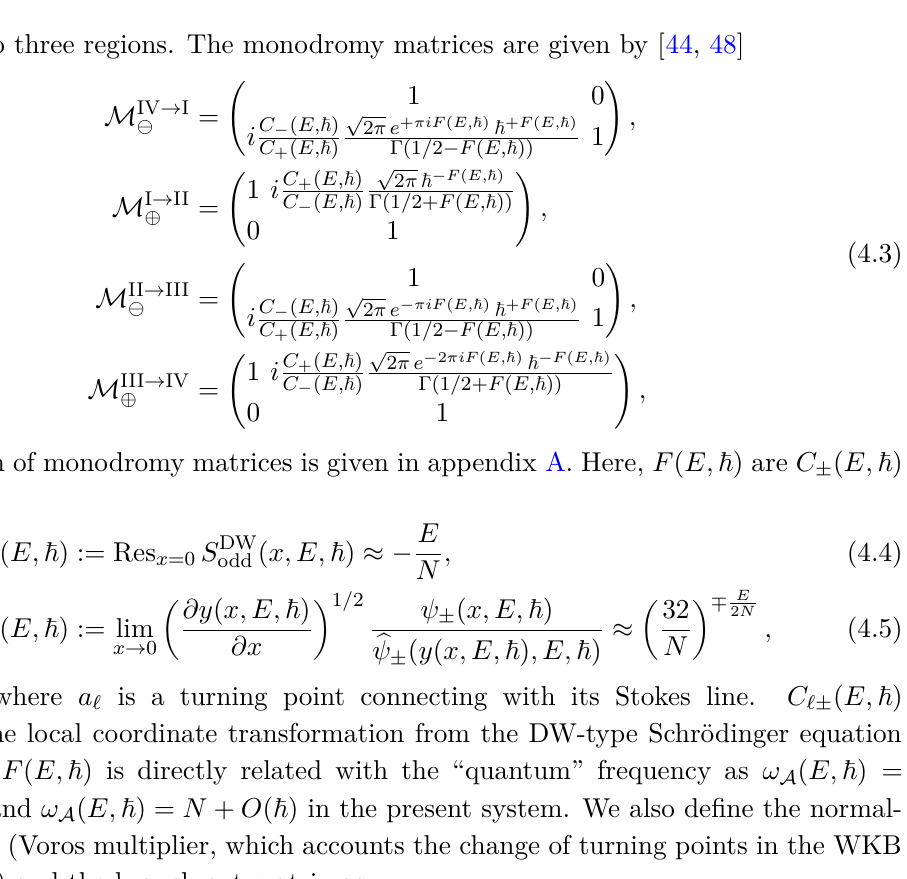
Figure 7 . The Stokes curve for the degenerate Weber equation. ± labels the asymptotics of b S odd , − 1 ( y )